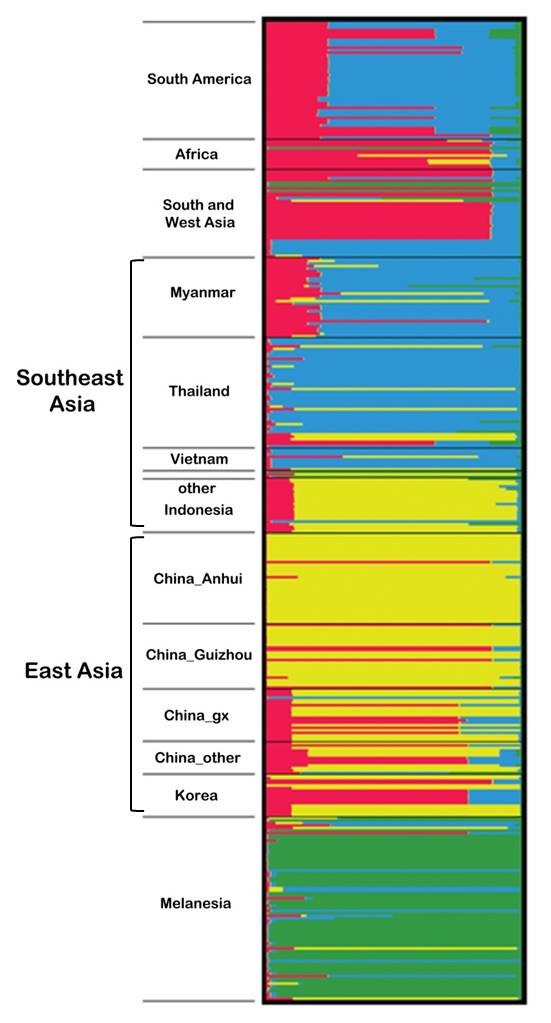
Graphical display of estimated population structure at K = 4. Each vertical line represents one individual. At K = 4, the samples are partitioned into four populations, which are consistent with large geographical regions of Melanesia, East Asia, Southeast Asia and the rest of the world. Populations are separated by black lines and occurred in the same order as given in Table 2.